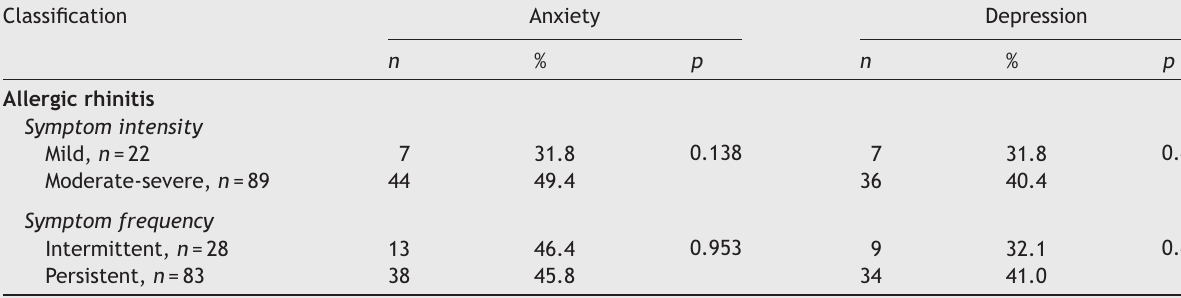
Frequency of anxiety and depression based on the classification of allergic rhinitis symptoms. Classification